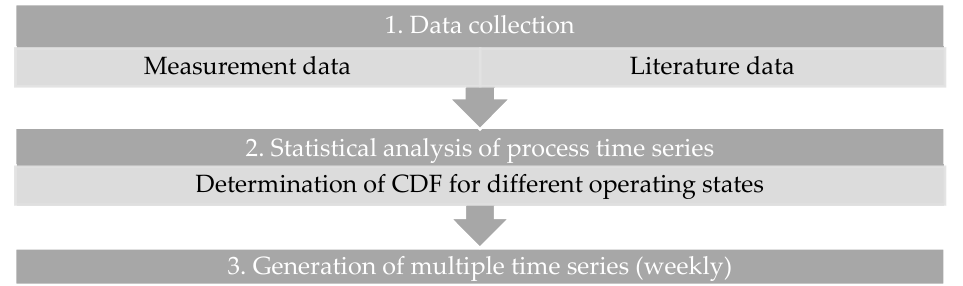
Figure 3. Flow chart of the approach for generating weekly time series of the heat source and sink processes.